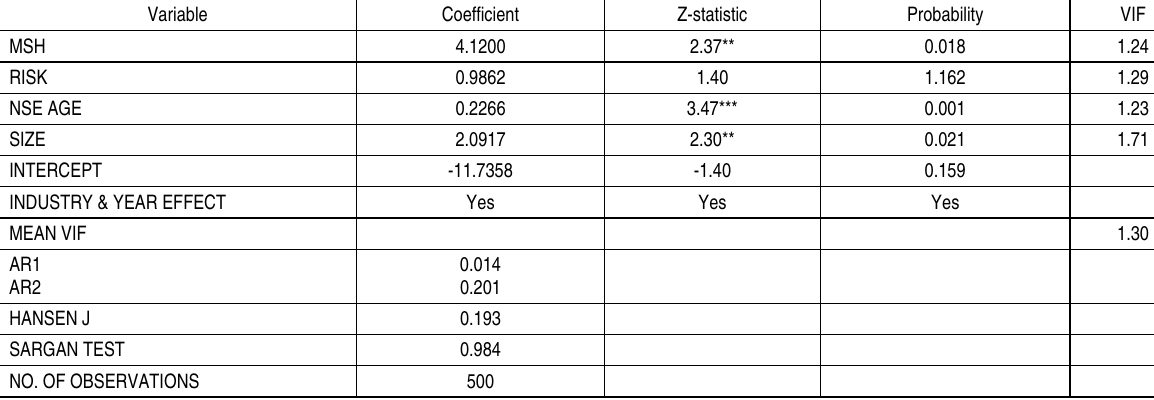
Table 4 (cont.). GMM regression